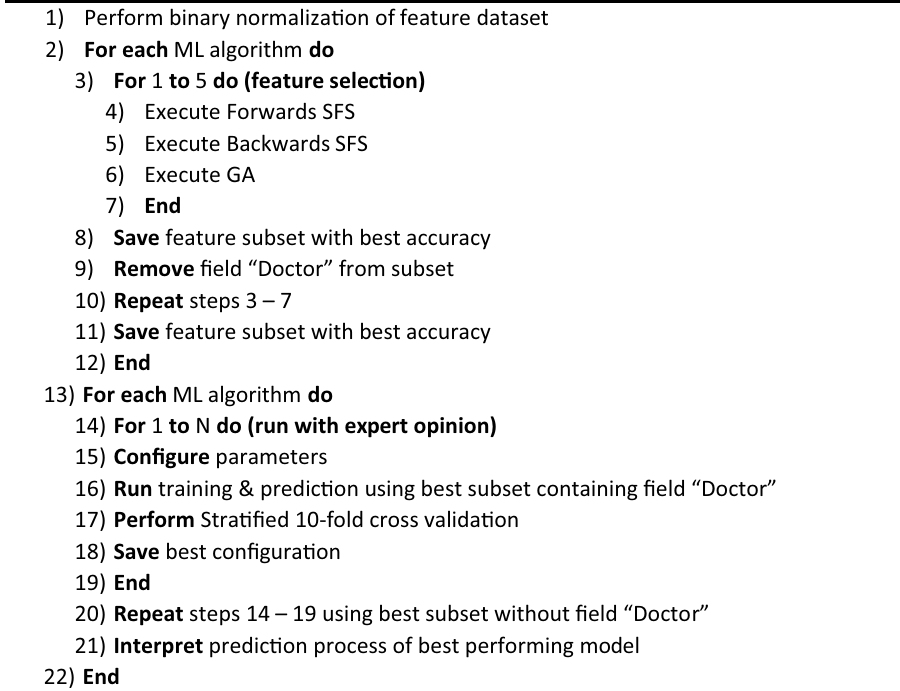
Algorithm 1 – ML predic(cid:21)on model crea(cid:21)on and evalua(cid:21)on